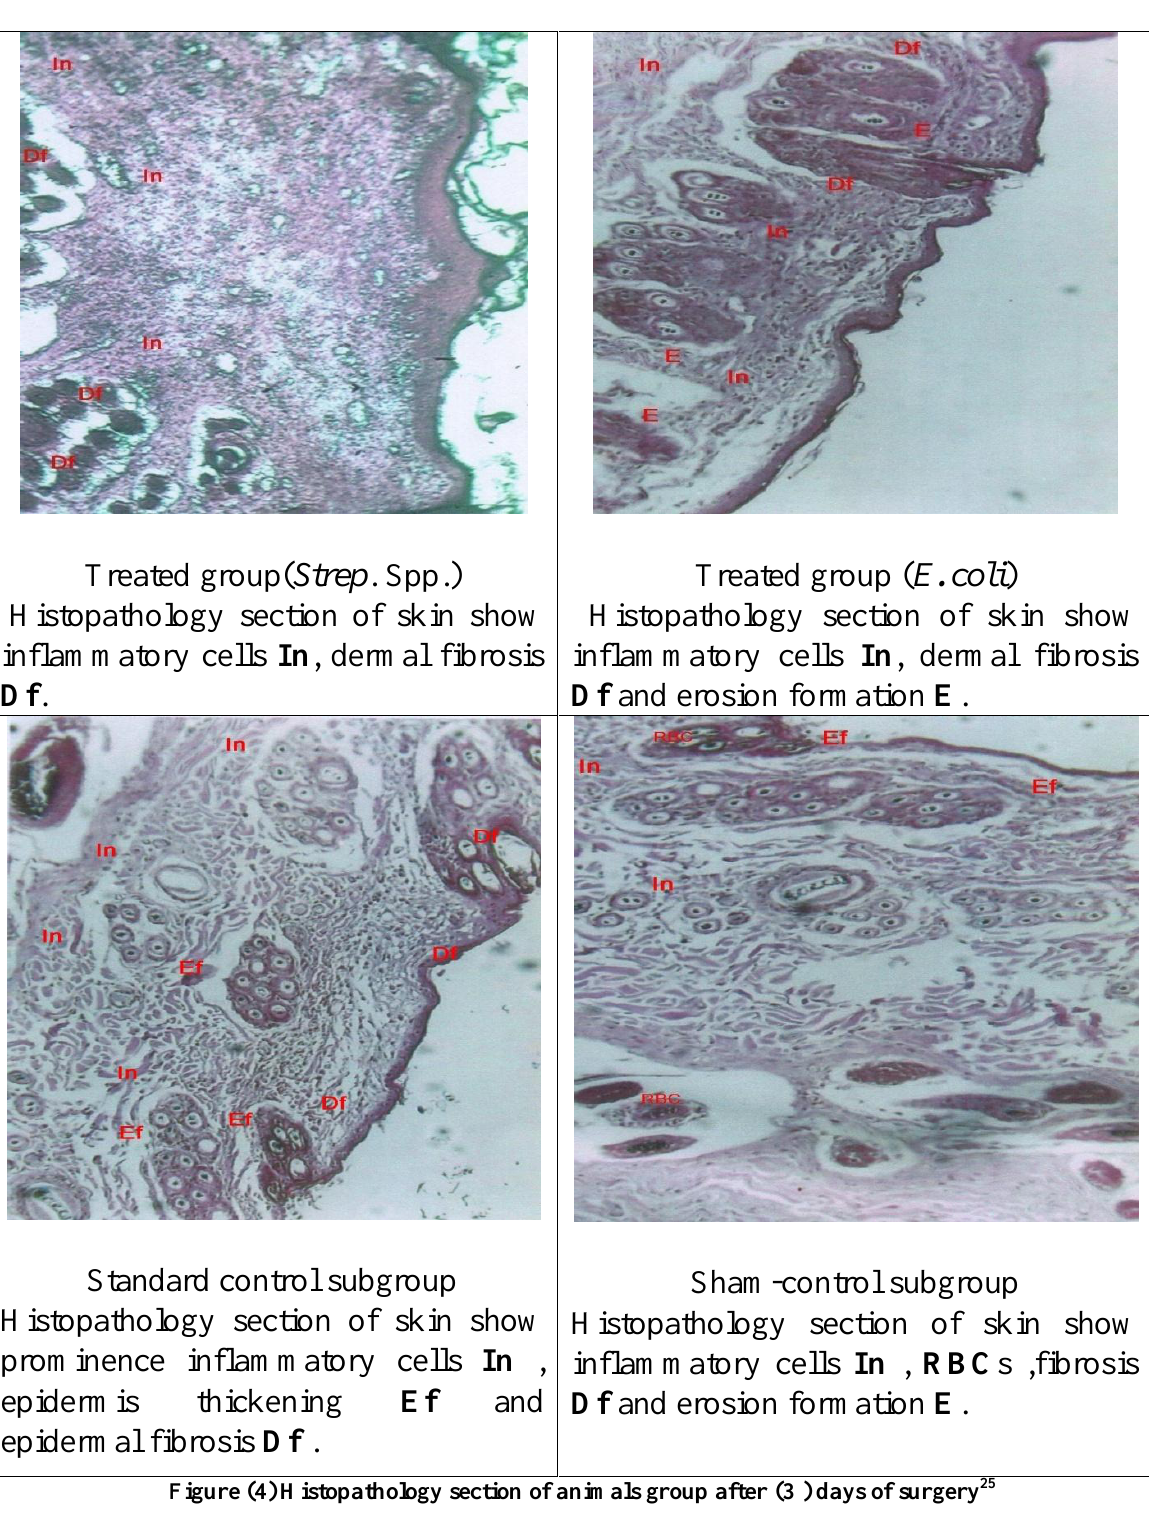
Figure (4) Histopathology section of animals group after (3 ) days of surgery